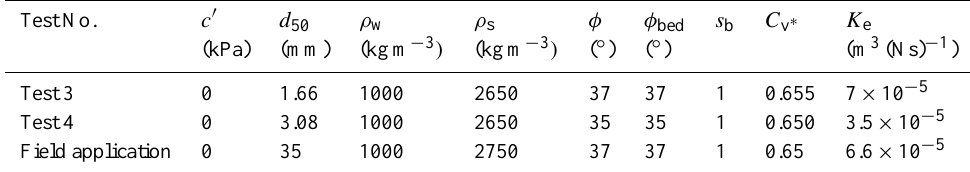
Table 1. Soil properties in Test 3, Test 4 and field application. Test No.